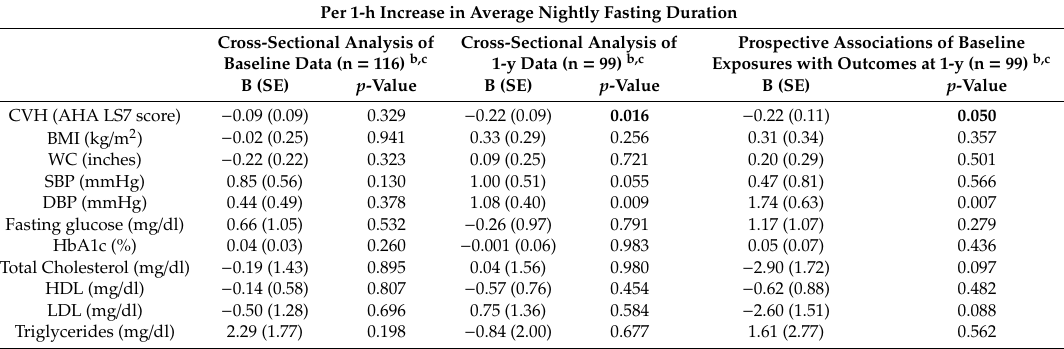
Table 2. Linear Regression Models for Cross-sectional and Prospective Associations of Habitual Nightly Fasting Duration (NFD) with Cardiovascular Health and Cardiometabolic Risk Factors a . Per 1-h Increase in Average Nightly Fasting Duration Cross-Sectional Analysis of Cross-Sectional Analysis of Baseline Data (n = 116) b,c 1-y Data (n = 99)